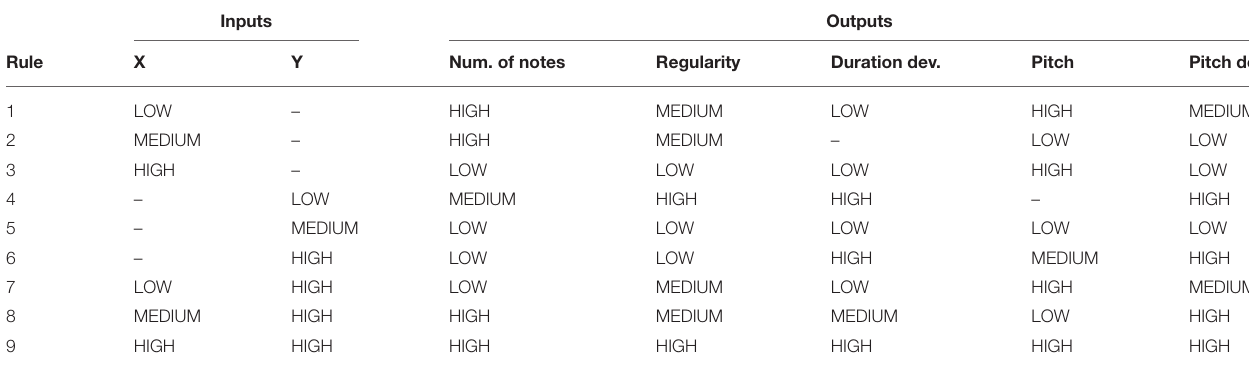
TABLE 2 | Fuzzy rules for the algorithmic composition example.